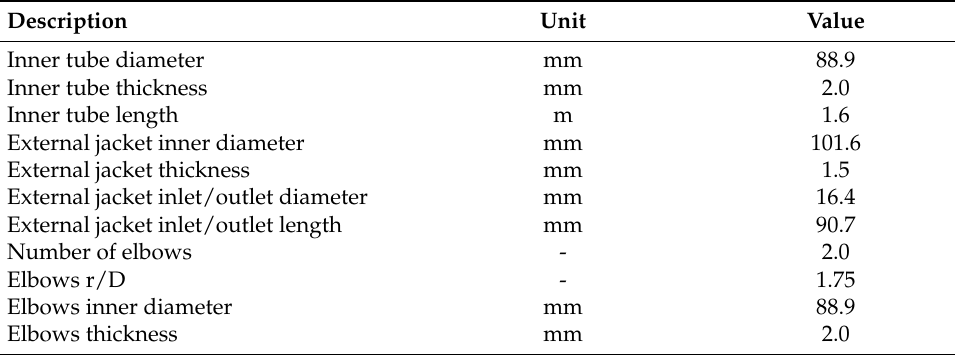
Table 1. Geometrical data of the tube-in-tube heat exchanger.